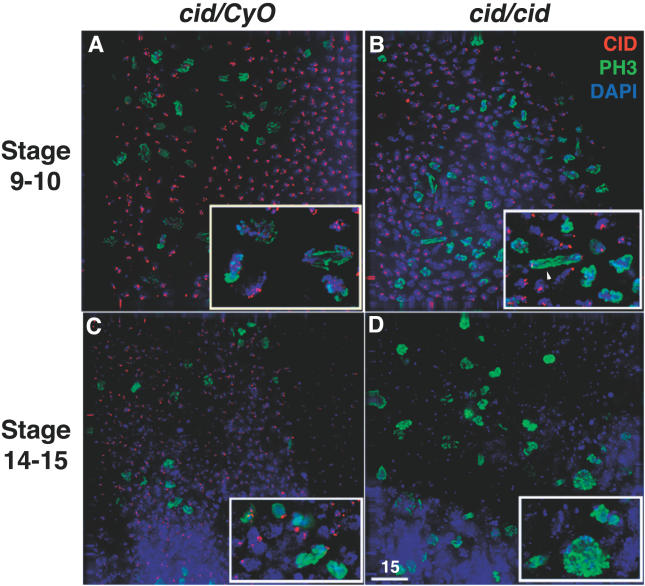

cid Null Embryos Exhibit Multiple Mitotic Phenotypes.CID, PH3, and DAPI staining of cid/CyO and cid/cid embryos at different stages of development were monitored to evaluate mitotic progression and segregation defects.(A) Heterozygous (cid/CyO) stage 9–10 embryos displayed no mitotic defects and robust CID staining at kinetochores (inset).(B) cid null animals (trans-heterozygous for different cid alleles, see Materials and Methods) exhibited lagging chromosomes during anaphase. Some CID staining was still visible at this stage, demonstrating that these phenotypes resulted from partial loss of CID function, due to the presence of maternal CID protein.(C) cid/CyO stage 14–15 embryos show normal mitotic progression and normal CID staining at kinetochores (inset).(D) cid null animals exhibited an elevated mitotic index, lower nuclear density, and little detectable CID staining in some cells at stage 14–15. The strong depletion of CID staining suggests that these phenotypes are the result of complete loss of zygotic cid function. cid null animals have a large number of presumably polyploidy cells (inset) suggesting high levels of aneuploidy due to repeated failures in cell division. Scale bar indicates 15 μm.